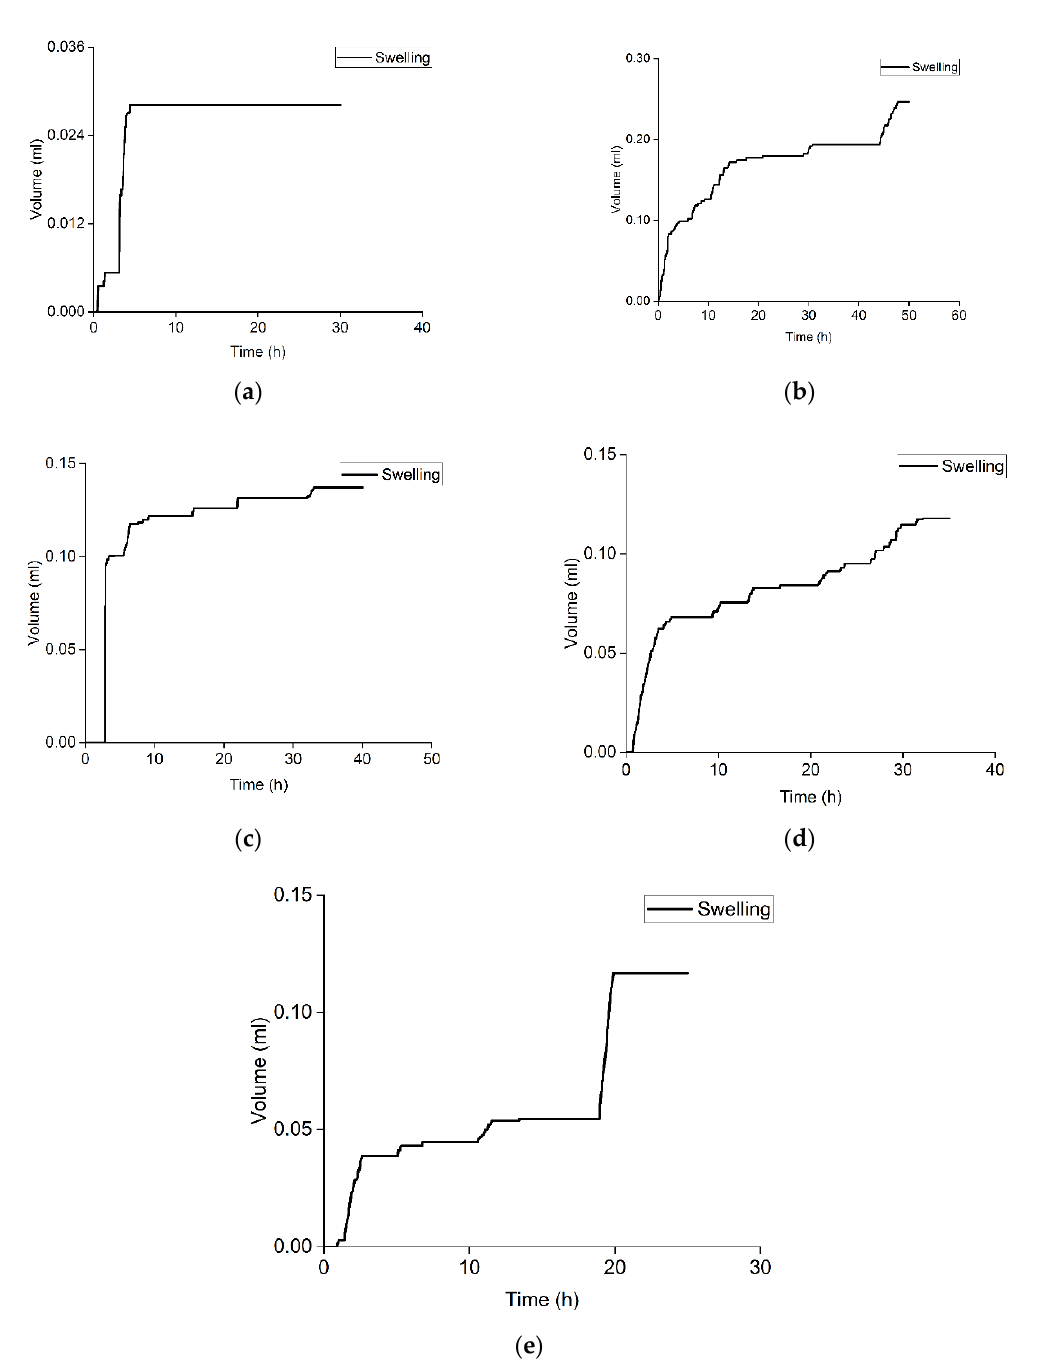
Figure 6. Sample rock volume change during swelling of the crushed rock samples in the hydro- carbon-based fluid in reservoir conditions, ( a – e ) for samples 1 – 5, respectively. hydrocarbon-based fluid in reservoir conditions, ( a – e ) for samples 1–5, Table 4. Results of the crushed rock swelling experiments in the presence of the hydrocarbon- based fracturing fluid.